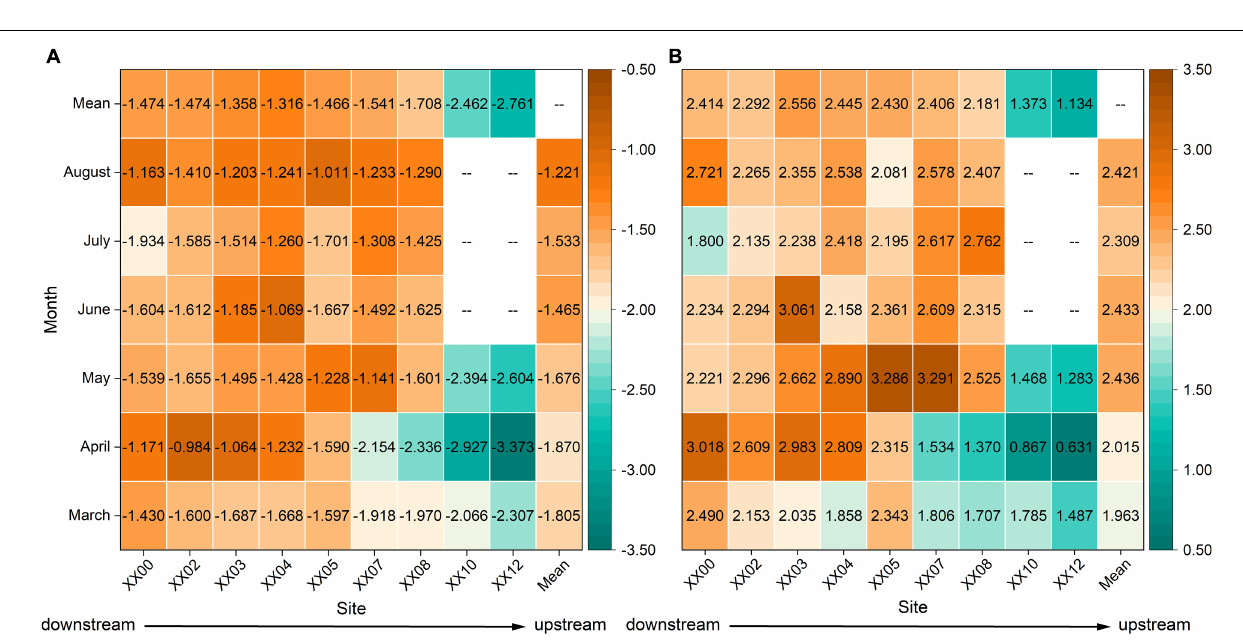
Frontiers in Ecology and Evolution |